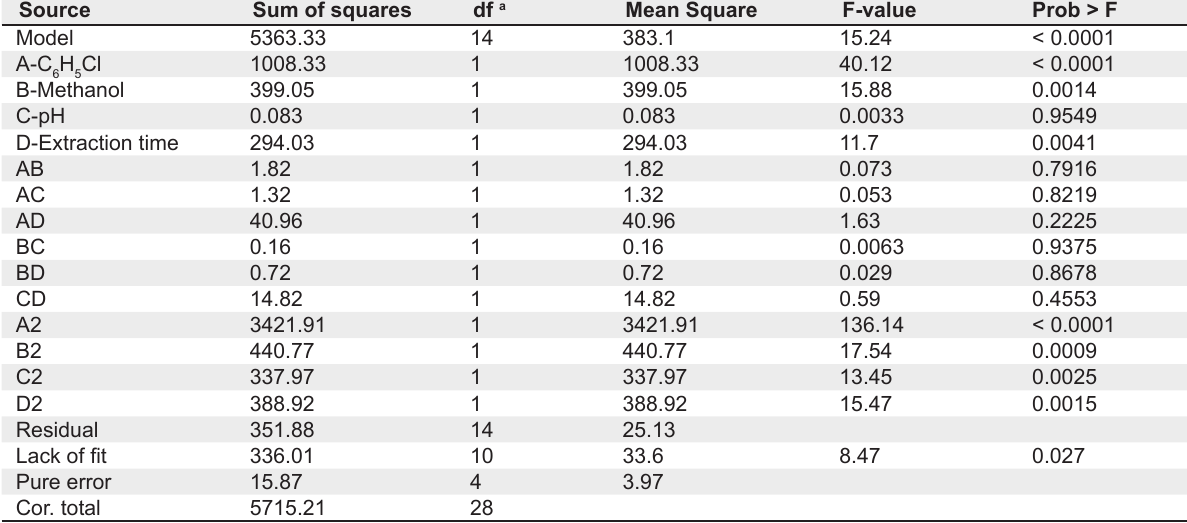
Table 3. Analysis of variance for the response of the average